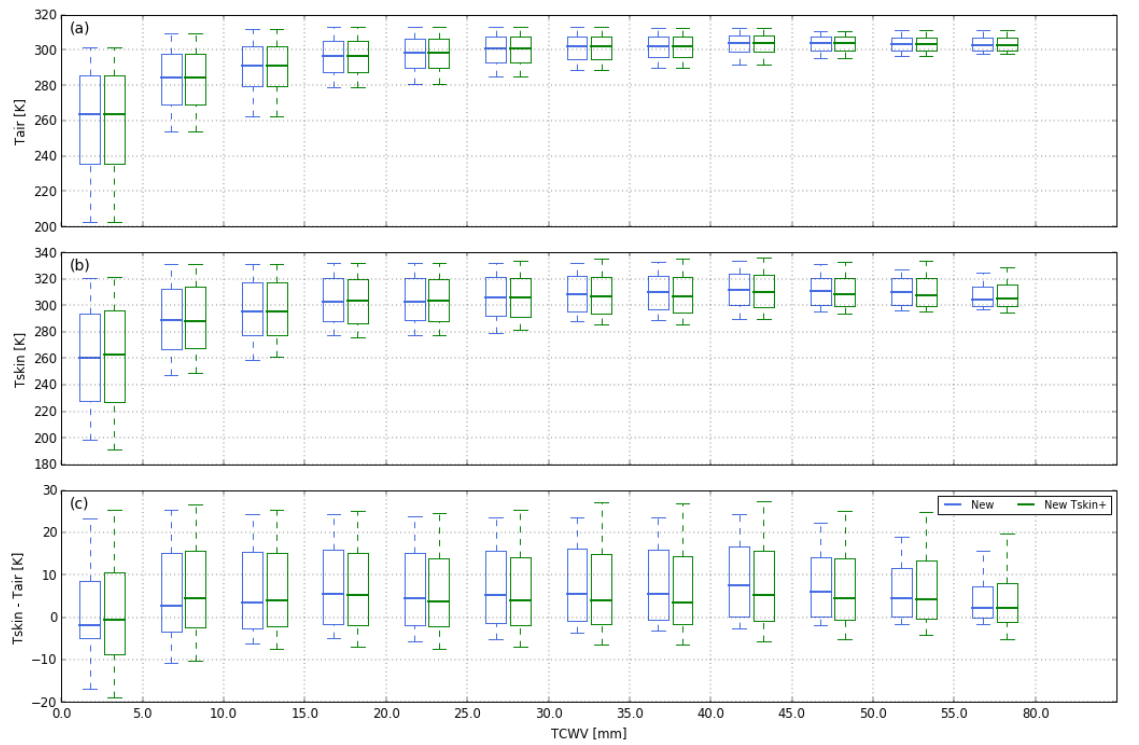
Figure 7. As in Figure 5 but showing the proposed calibration database with extended Tskin range (Tskin+; green). Distribution of the ( a ) surface air temperature (Tair), ( b ) skin temperature (Tskin), and ( c ) the difference between skin and surface air temperatures for each TCWV